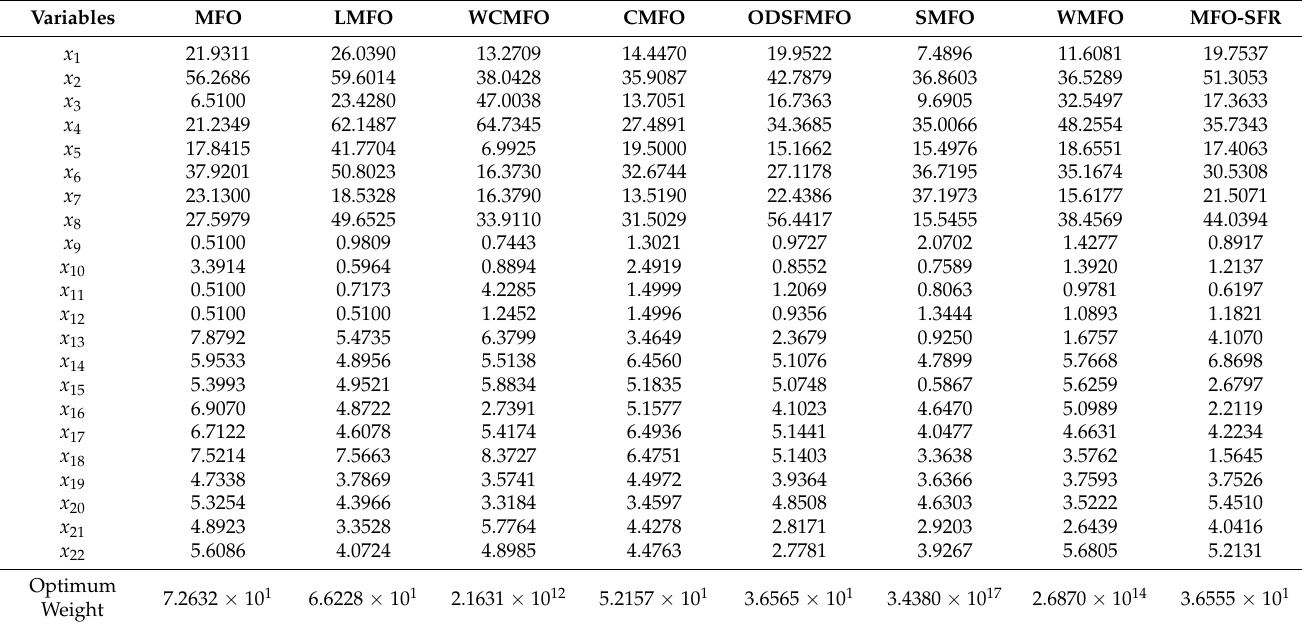
Table 10. Comparison of the results obtained for the four-stage gearbox